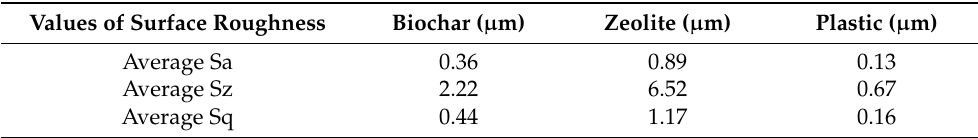
Figure 7. The 3D surface profilometry of ( A ) biochar and ( B ) zeolite, and ( C ) plastic media used in this study. Table 4. The values of surface roughness for the three types of